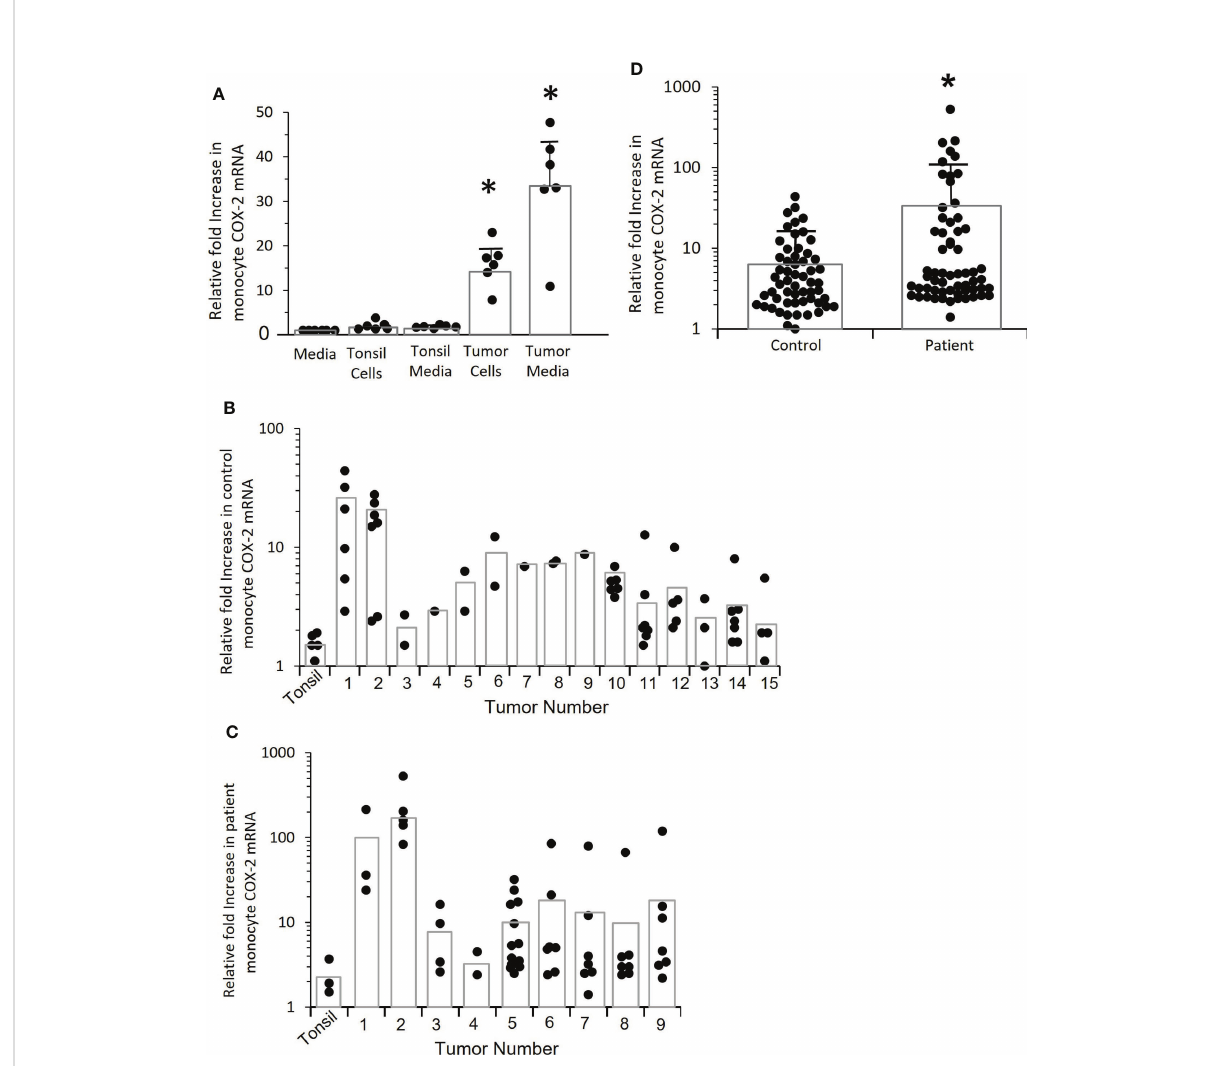
FIGURE 4 Tumor cells induce increased COX-2 expression in control and patient-derived monocytes, patient monocytes are hyper-responsive. (A) Monocytes from controls were co-cultured with tumor cells derived from two OPC biopsies for 24 hrs. or incubated with conditioned medium obtained from the tumor cells, and COX-2 mRNA measured by q-RT-PCR (*p=0.004). Normal tonsil keratinocytes and conditioned medium from tonsil cells served as controls. Results shown are relative to monocytes incubated with fresh media. Each dot within a given condition indicates a different preparation of monocytes (n=6), bars indicate mean ± SD. Both the tumor cells and the conditioned medium signi fi cantly increased COX-2 mRNA (p=0.004, p=0.004 respectively, Mann-Whitney test). (B) Monocytes from controls were stimulated with conditioned media from 15 different tumor biopsy cultures or early passage tonsil keratinocytes (*p=0.002). Each dot within a given condition is a different preparation of monocytes. Bars indicate mean COX-2 mRNA levels relative to monocytes treated with fresh medium (not shown). (C) OPC patient-derived monocytes were stimulated with conditioned medium from the fi rst nine tumors shown in “ B ” or with tonsil-conditioned media. Each dot within a given condition is a different preparation of monocytes. Bars indicate mean COX-2 mRNA levels relative to monocytes treated with fresh medium (not shown). (D) Data from tumor-conditioned media results in (B, C) was pooled for both control and patient monocytes and expressed relative to monocytes treated with fresh media (not shown). Bars indicate mean ± SD. There was a signi fi cantly increased response by patients ’ monocytes compared to control monocytes (p=0.01, Mann-Whitney